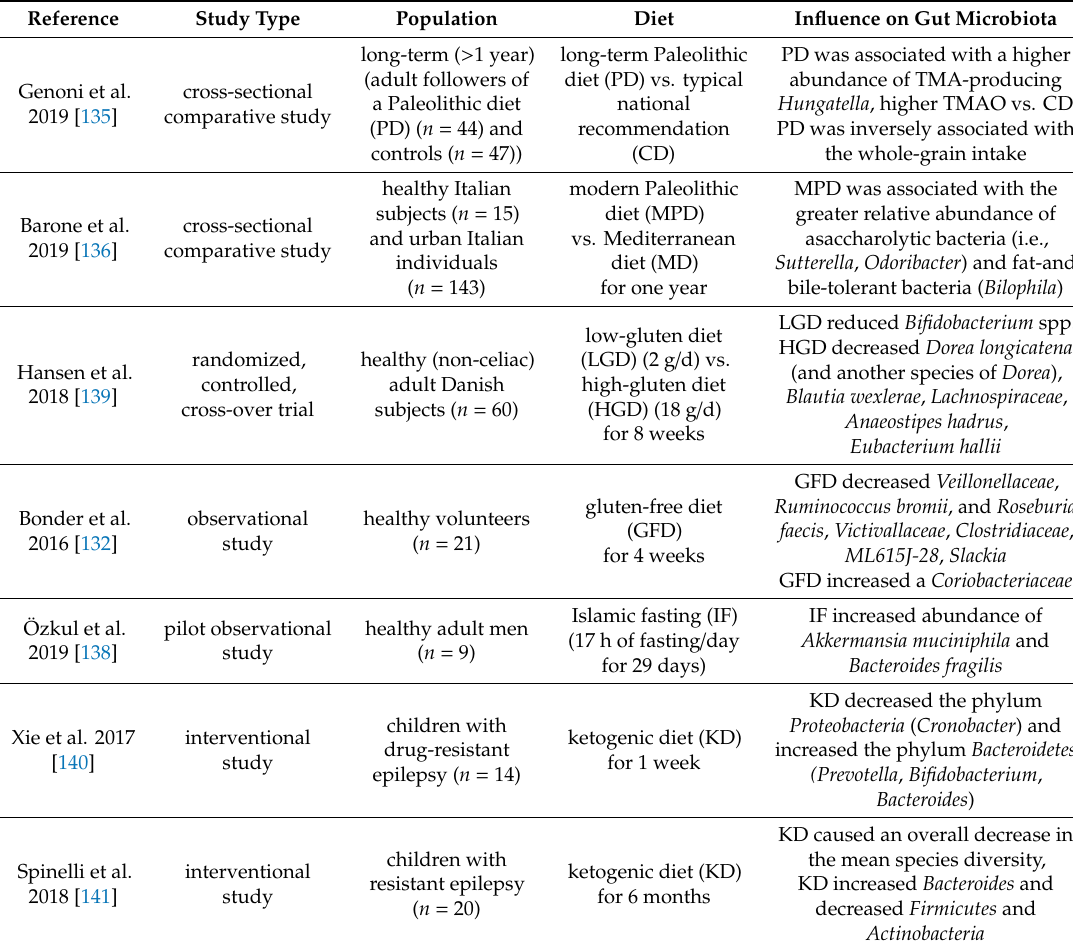
Table 5. Influence of selected dietary patterns on